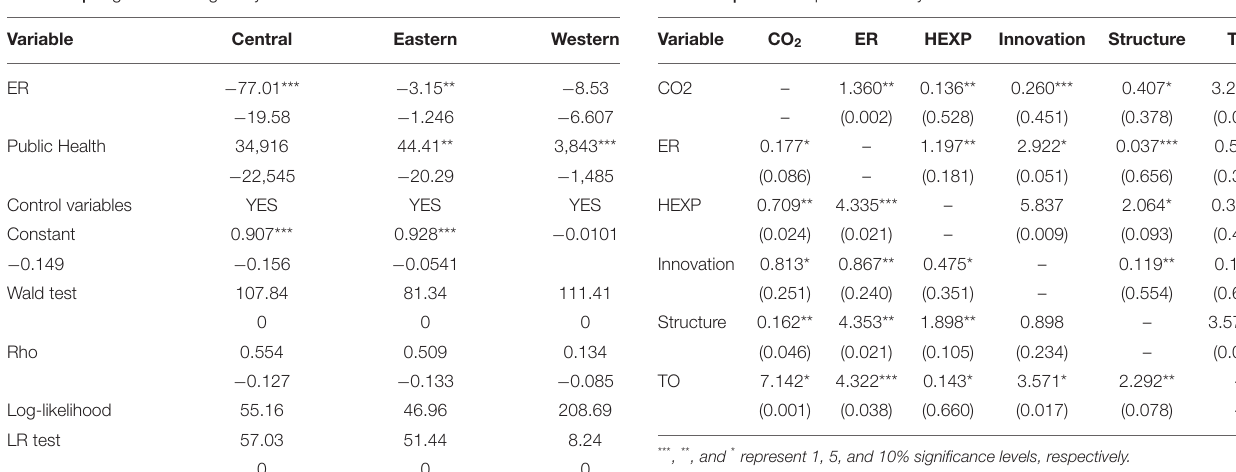
TABLE 8 | Pair-wise panel causality tests.